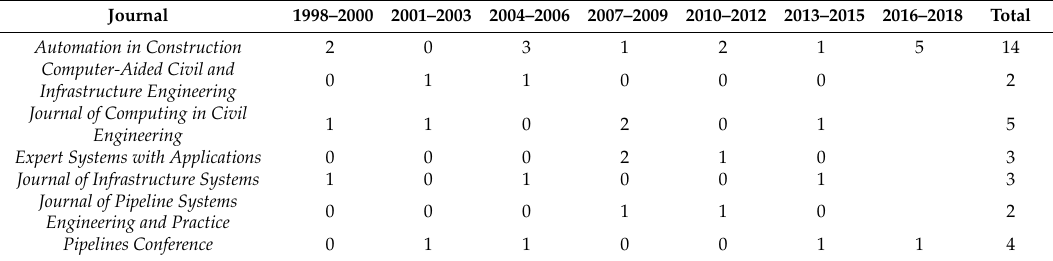
Table 1. Publications in popular journals over time.